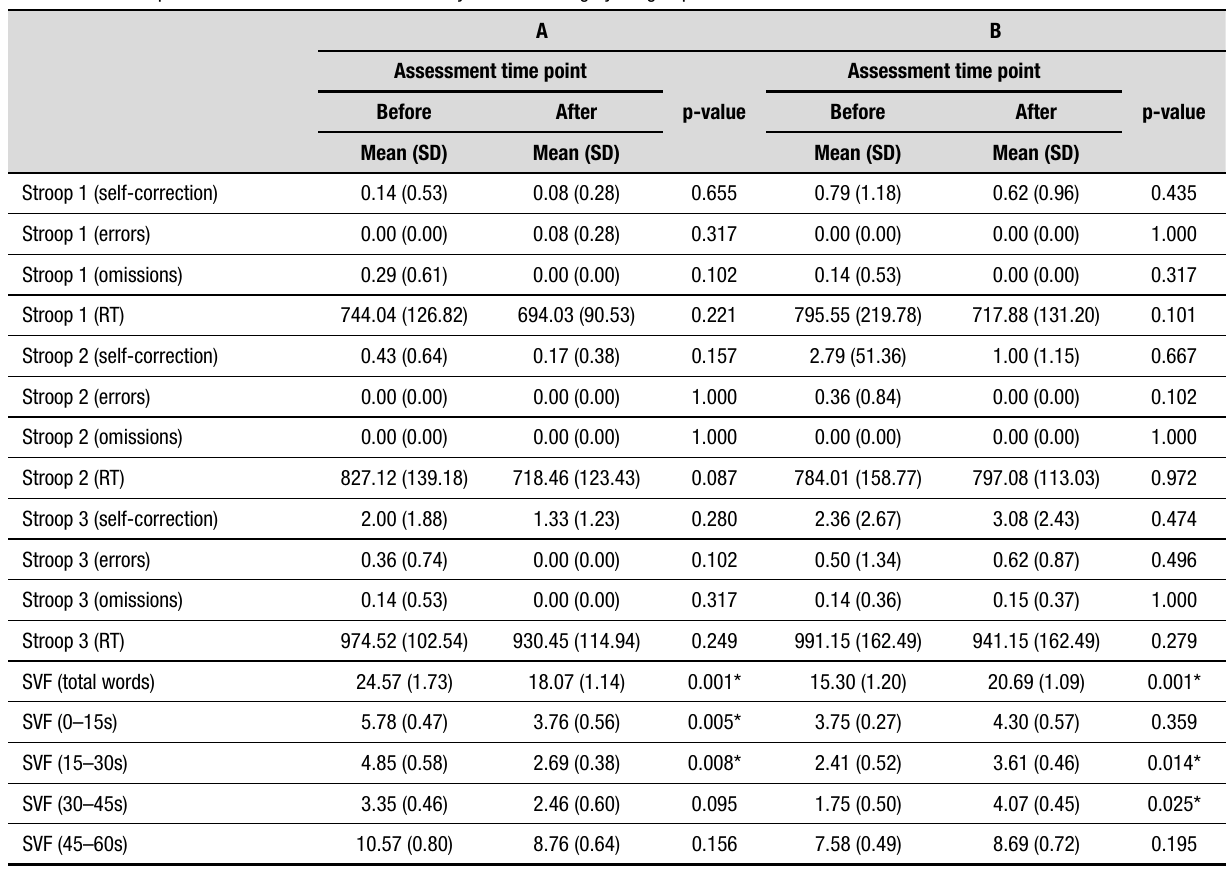
Table 3. Executive performance before and after inhibitory control training by subgroups A and B.